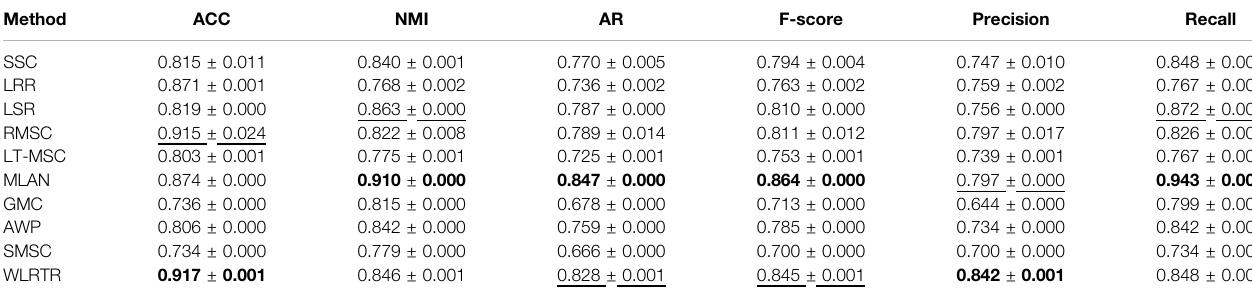
TABLE 3 | Clustering results on UCI-3views